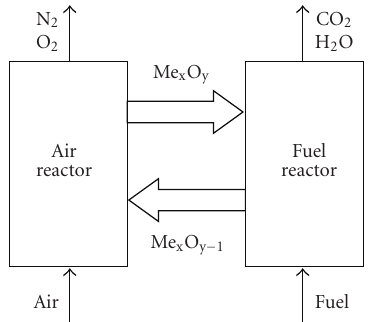
Figure 1: Chemical-looping combustion